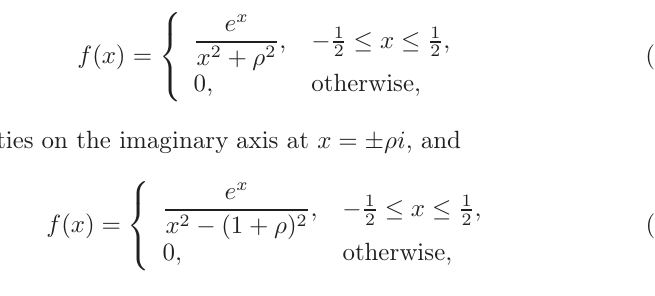
versus ρ (bottom right graph) for m = 3 , 6 , 9 , 12 , 15 + q N R, 2 T